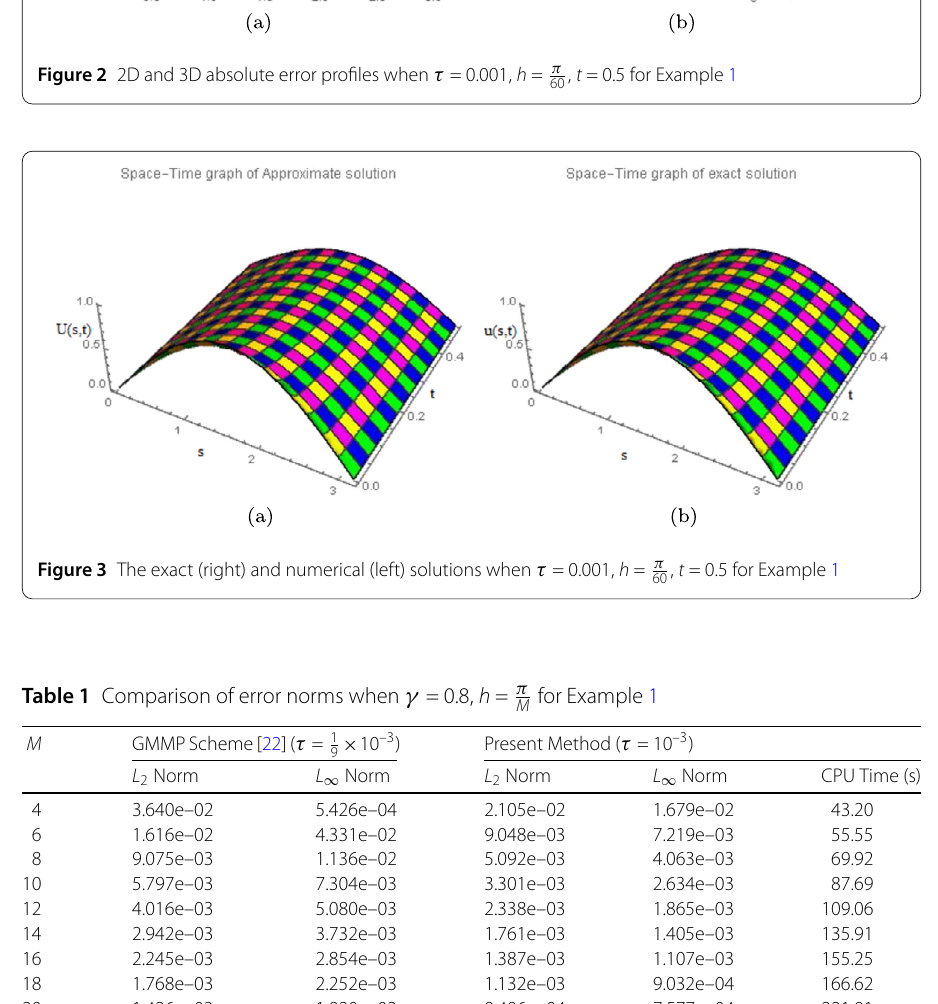
Figure 2 2D and 3D absolute error profiles when τ = 0.001, h = π